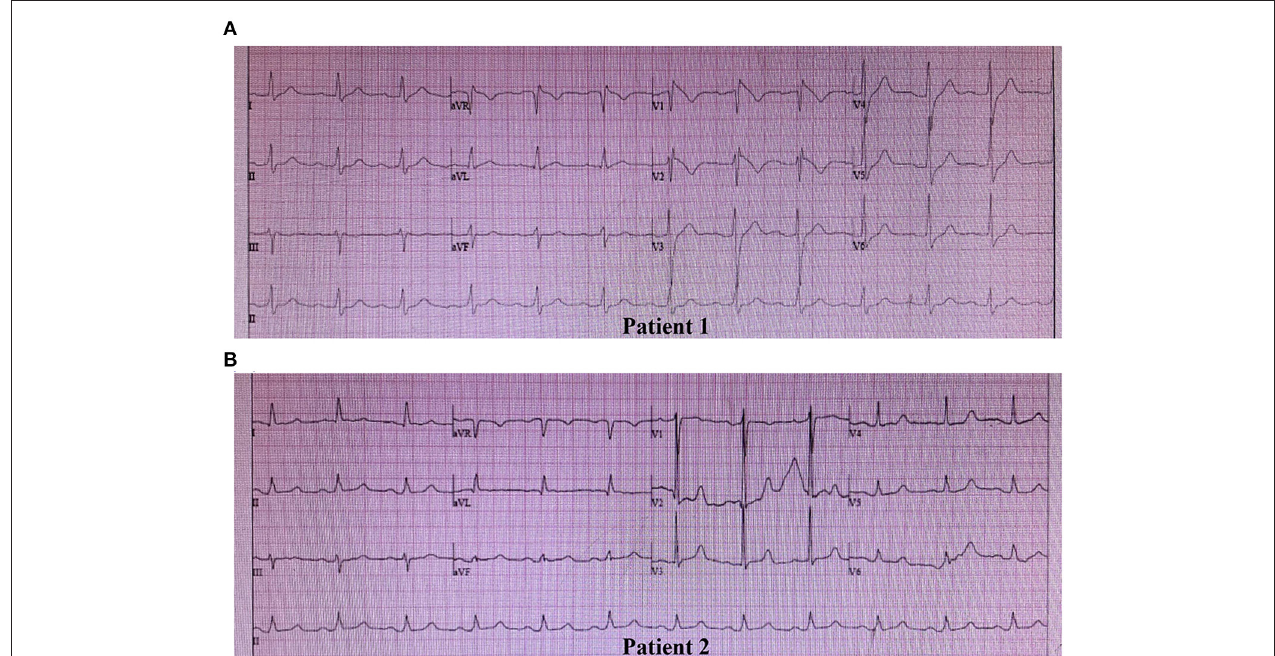
FIGURE 1 | Spontaneous electrocardiogram (ECG) of two patients. (A) ECG of Patient 1: Type 1 Brugada pattern displaying a coved-type ST-segment ( ≥ 2mm) and negative T wave in V1 and V2, a first-degree atrioventricular block pattern, and an incomplete right bundle branch block. (B) ECG of Patient 2: Type 3 Brugada pattern displaying a saddleback ST-segment ( < 1mm) in V2, and a first-degree atrioventricular block pattern.